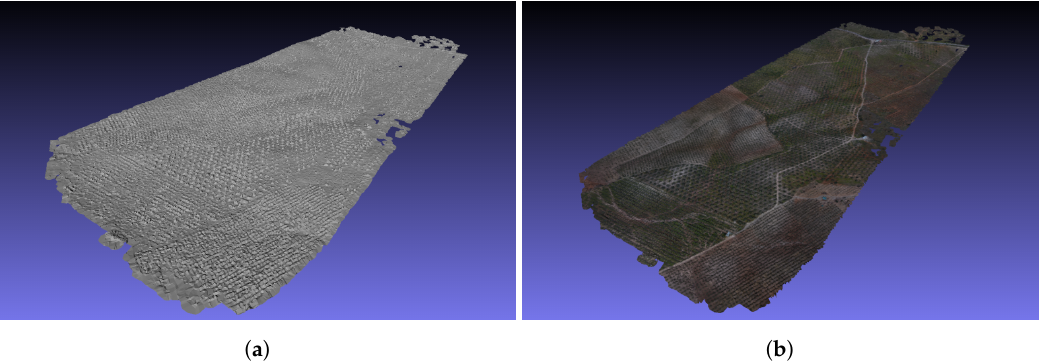
Figure 11. High quality 3D map reconstruction using OpenDroneMap. ( a ) 3D mesh model. ( b ) 3D texture